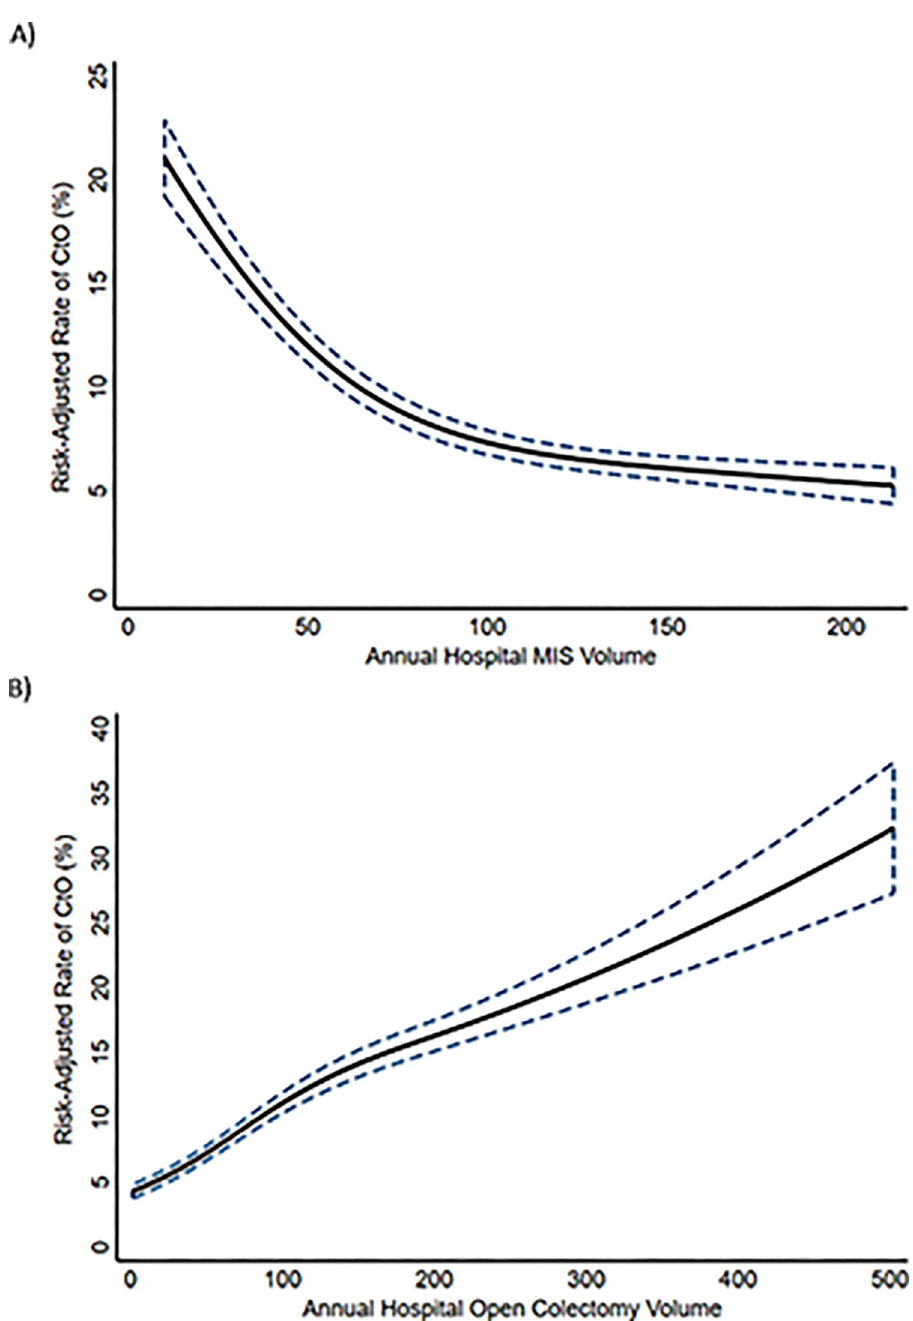
Fig 3. Relationship between annual hospital colectomy volume modeled using cubic splines (A: minimally invasive surgery (MIS); B: Open) and risk-adjusted rates of conversion to open (CtO).